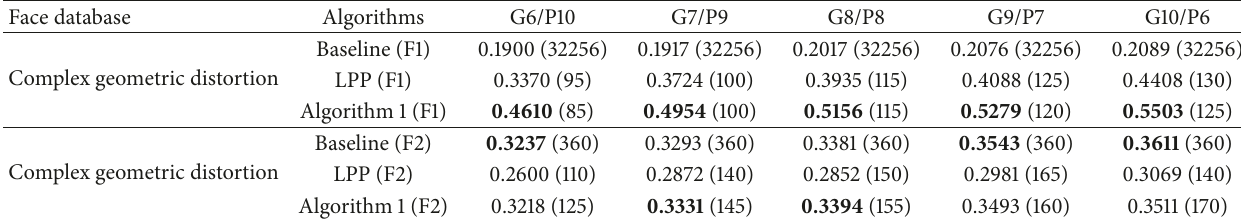
Table 19: The recognition rates on complex geometric distortion Extended Yale B face database over “F1” and “F2” features; recognition